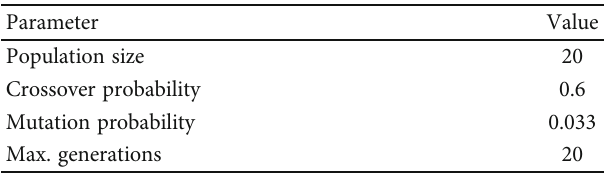
Figure 5: Random forest classi fi er [37]. Table 1: WEKA genetic search